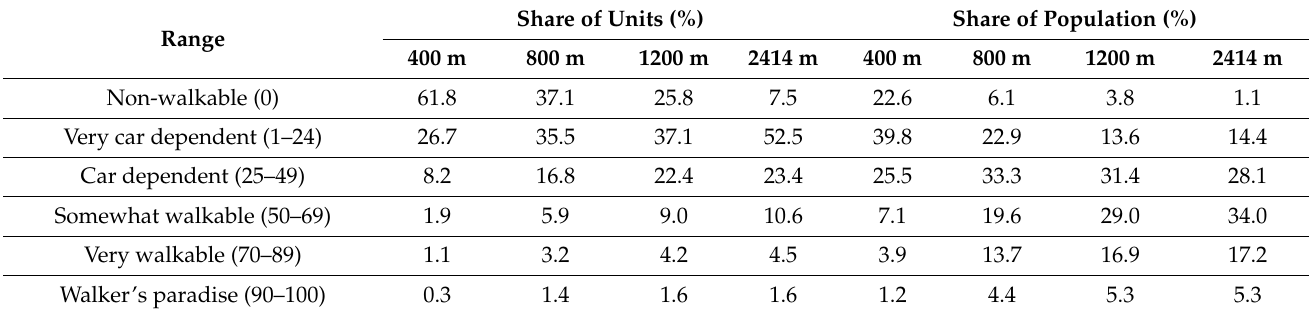
Table 3. Distribution of WS for different search radii in Ostrava.